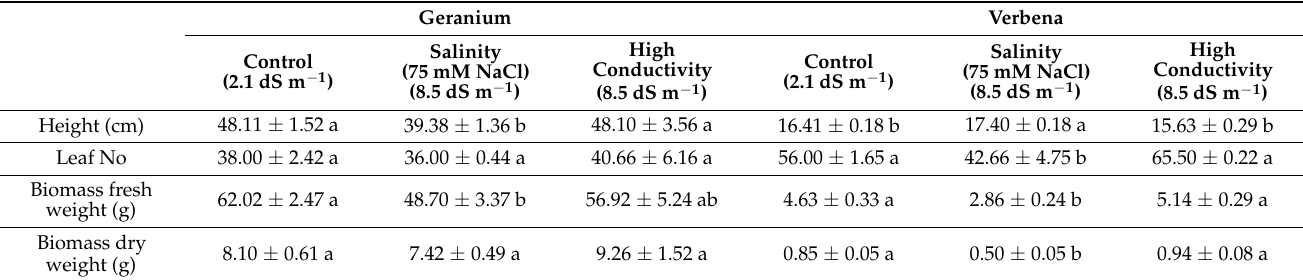
Table 1. Influence of salinity (75 mM NaCl; 8.5 dS m − 1 ) and high conductivity (8.5 dS m − 1 ) on plant height (cm), number of leaves, and fresh and dry weight biomass (g) of geranium and verbena plants grown hydroponically in perlite substrate (mean ± SE, n =